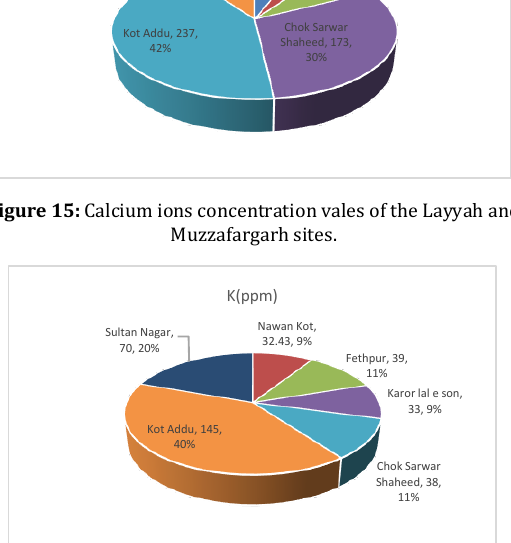
Figure 16: Potassium concentrations of soil samples of district Layyah and Muzaffargarh sites.